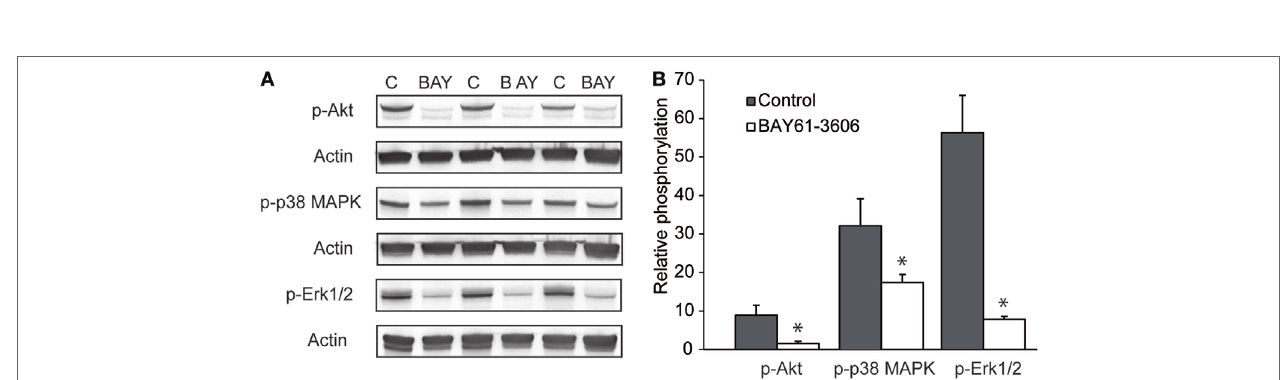
FigUre 7 | Pharmacological inhibition of SYK ablates signaling events in immune complex-activated polymorphonuclear leukocyte (PMN). (a) Representative blots from immune complex-activated PMN (“C”) or activated PMNs treated with BAY61-3606 (“BAY”) from three blood donors. (B) Image analysis showed that BAY61-3606 ablated pAkt phosphorylation and significantly reduced p38 and Erk phosphorylation. The data are presented as the mean (boxes) and STD (error bars) and are based on three experiments per group (* p < 0.05, t